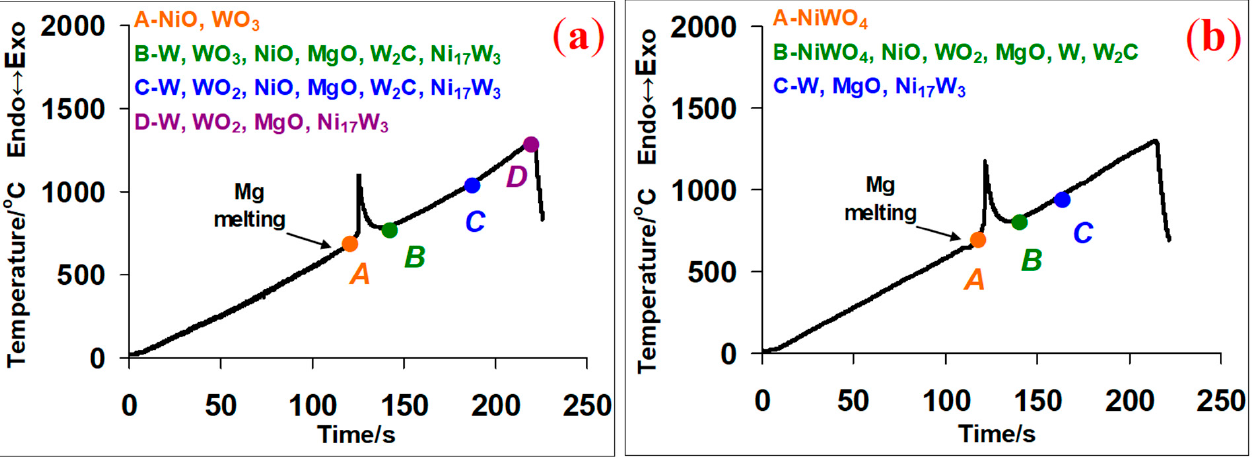
Figure 3. Heating curves of the NiO + WO 3 + 2.5Mg + 1.5C (( a ) A—725 °C, B—800 °C, C—1060 °C and D—1300 °C) and NiWO 4 + 2Mg + 2C (( b ) A—720 °C, B—830 °C and C—1000 °C) mixtures, β = 300 °C min −1 .